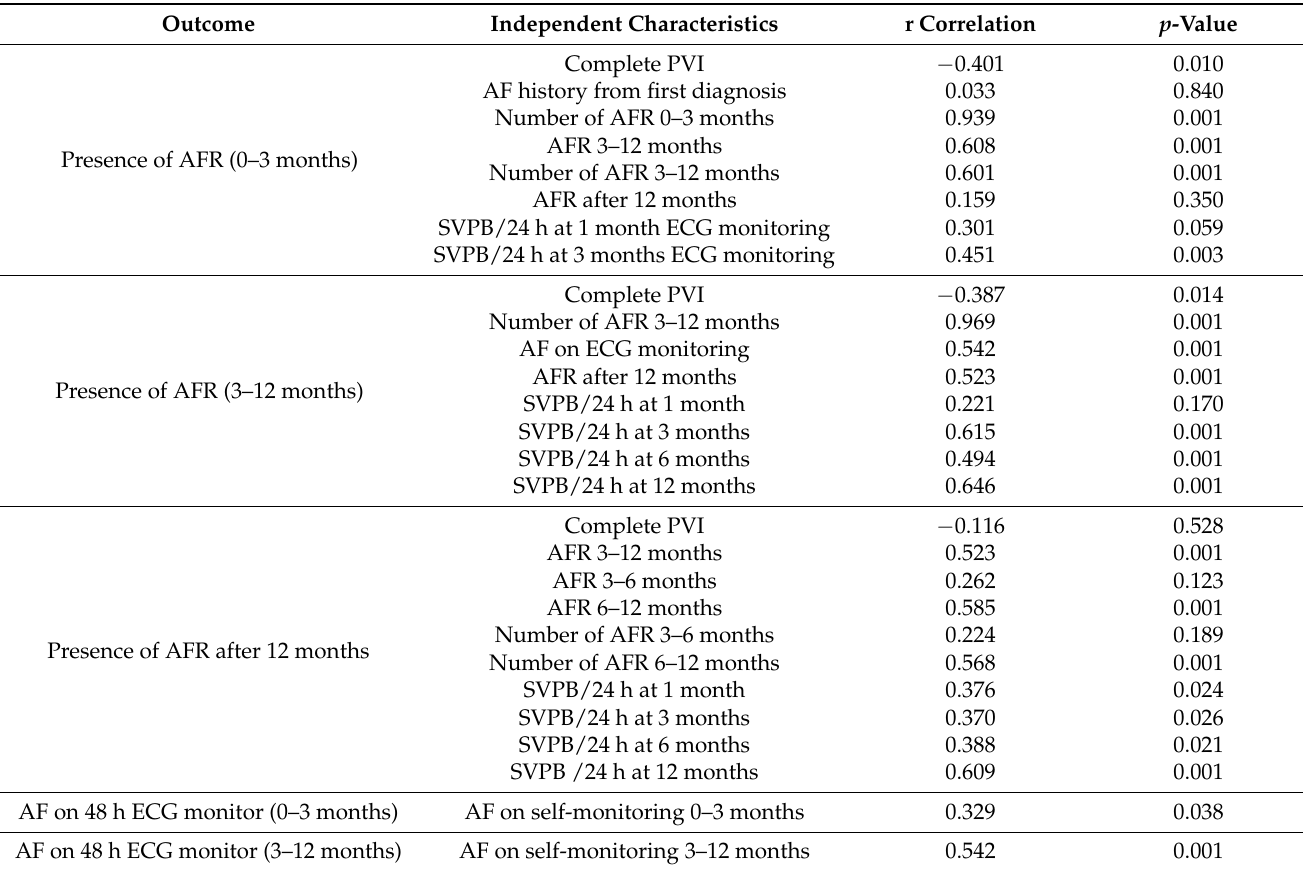
Table A1. Atrial fibrillation recurrences correlations.